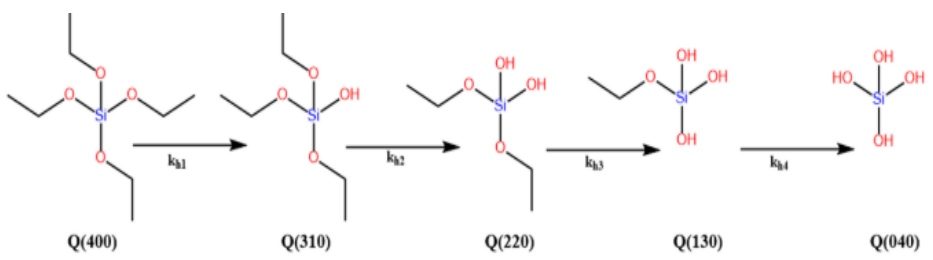
Figure 5. Different degrees of hydrolysed TEOS [56].